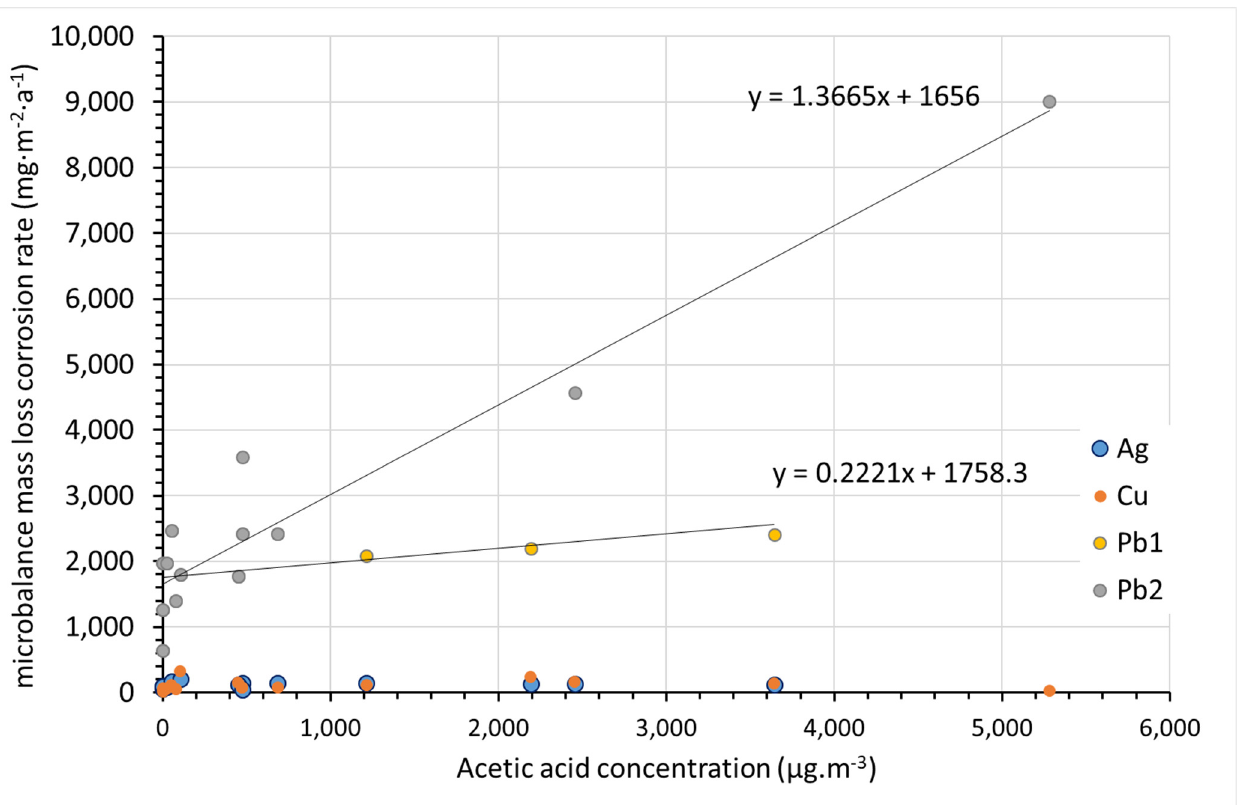
Figure 15. Influence of atmospheric acetic acid concentration on corrosion rate of metals. Acetic acid concentration was quantified by PDTs at start of coupon exposure. (Note: Lead samples from Pb1 and Pb2 datasets do not differ in principle, but follow a different trend of corrosion rate vs. VOA content.).